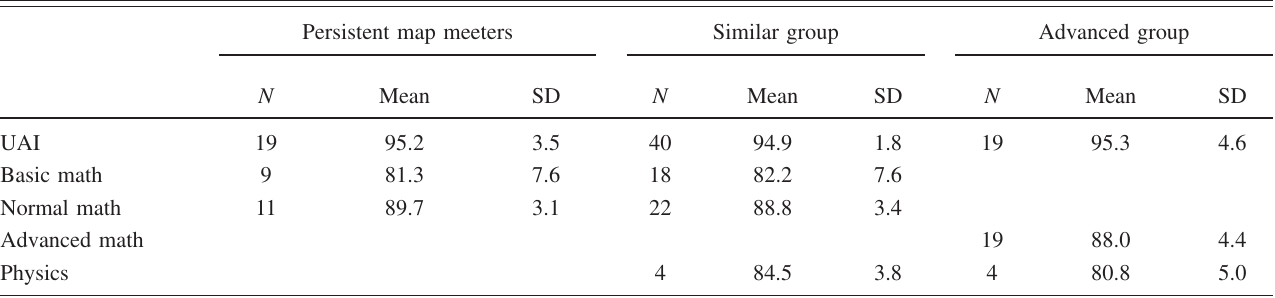
TABLE III. Descriptive statistics of the background of persistent map meeters and the similar and advanced groups.